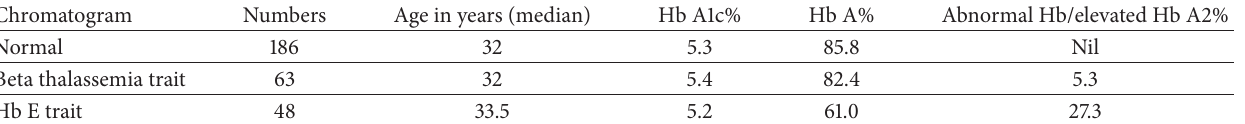
Table 1: Median of various hemoglobin fractions separated by chromatography.